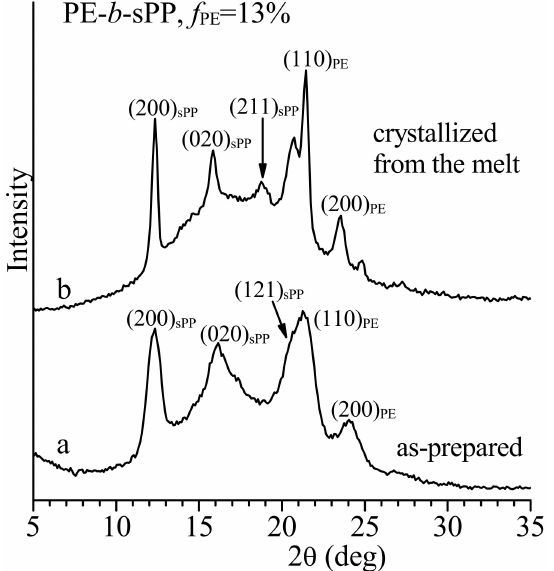
Figure 2. X-ray powder diffraction profiles of as-prepared specimen (a) and of sample crystallized from the melt by cooling the melt at 10 ◦ C/min (b) of the BCP sample PE- b -sPP with f PE = 13%. The (200) sPP , (020) sPP , (211) sPP and (121) sPP reflections of form I of sPP at 2 θ = 12.2 ◦ , 16 ◦ , 18.8 ◦ and 20.7 ◦ and the (110) PE and (200) PE reflections at 2 θ = 21.4 ◦ and 23.9 ◦ of the orthorhombic form of PE are indicated.